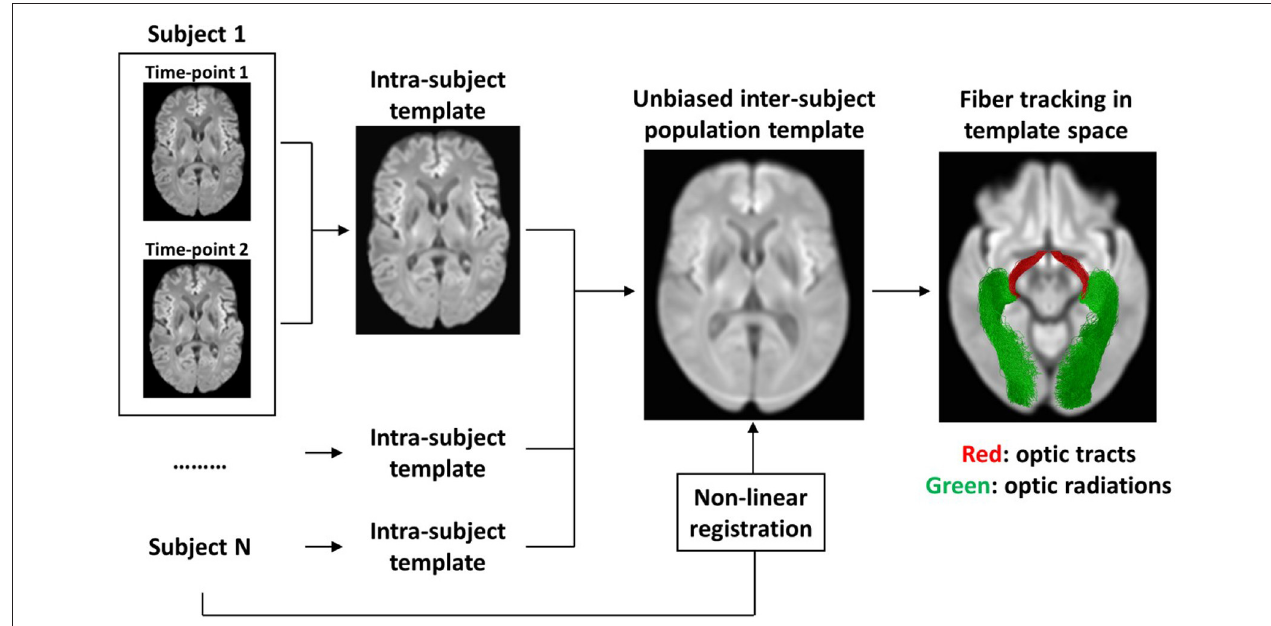
FIGURE 1 | Flow-chart summarizing the main steps for creating an unbiased longitudinal population template. First, an intra-subject template was created from TP1 and TP2 scans of each participant individually. Then, the intra-subject templates of all participants were used to create an unbiased inter-subject population template. To achieve spatial correspondence between all participants in template space, each of the participant’s scans were warped from native space to template space using non-linear registration. To specifically analyze the visual pathways, the OTs and the ORs were tracked using probabilistic tractography in template space.